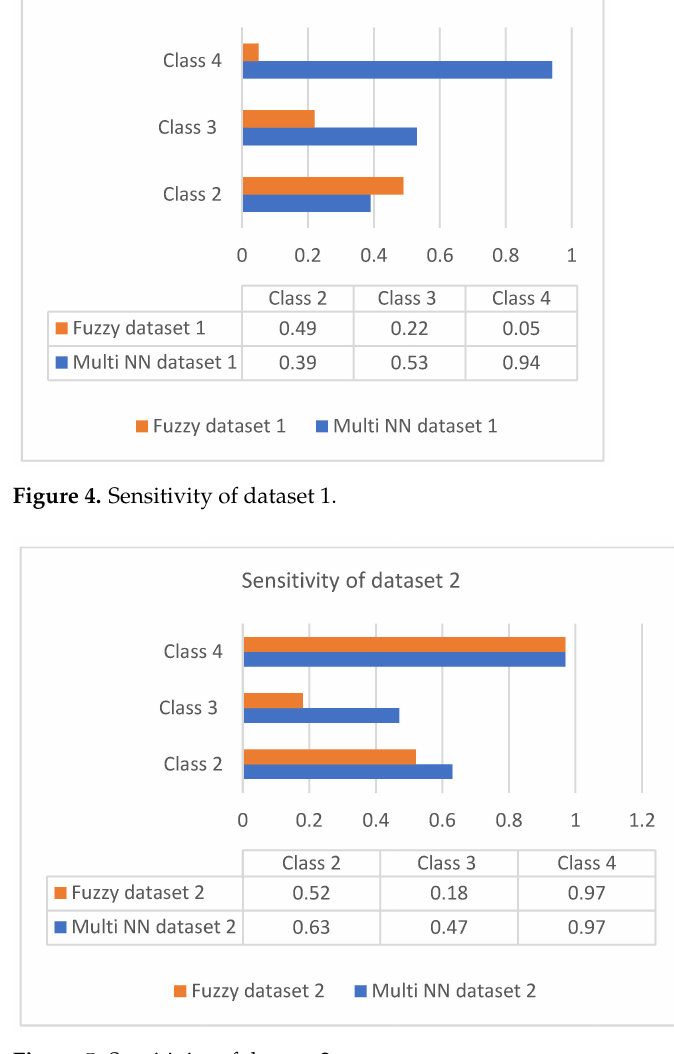
Figure 5. Sensitivity of dataset